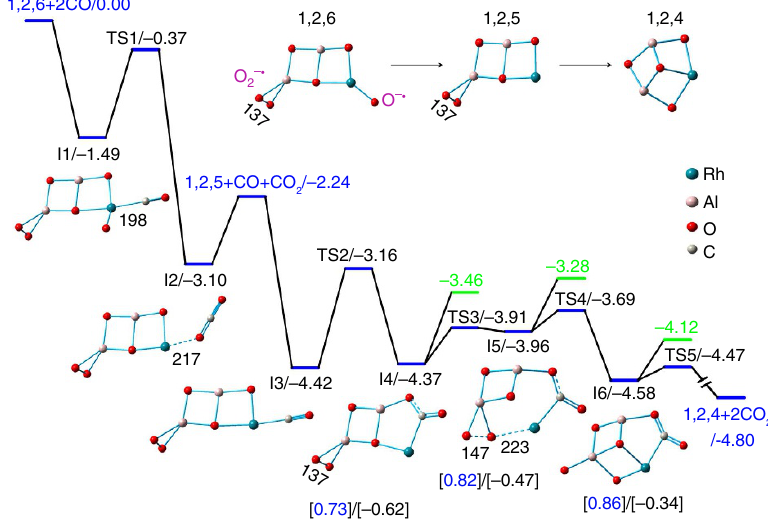
Figure 5 | Structures and reaction mechanisms. Density functional theory (DFT)-calculated potential energy profiles for the oxidation of the first two CO molecules by RhAl 2 O 6 þ . The lowest energy structure of RhAl 2 O 6 þ (1,2,6) and the products P RhAl 2 O 5 þ (1,2,5) and RhAl 2 O 4 þ (1,2,4) are provided. Symbols O 2 (cid:2)(cid:3) and O (cid:2)(cid:3) denote superoxide and atomic oxygen radical species, respectively. The relative energies for intermediates (I1–I6) and transition states (TS1–TS5) are in unit of eV. Structures of I1–I6 are shown. Bond lengths are given in pm. The values in green show the relative energies for direct CO 2 desorption from I4 to I6. The values in the square brackets show the natural charges on Rh (blue) and CO 2 unit (black). See also Supplementary Figs 9–13 for more